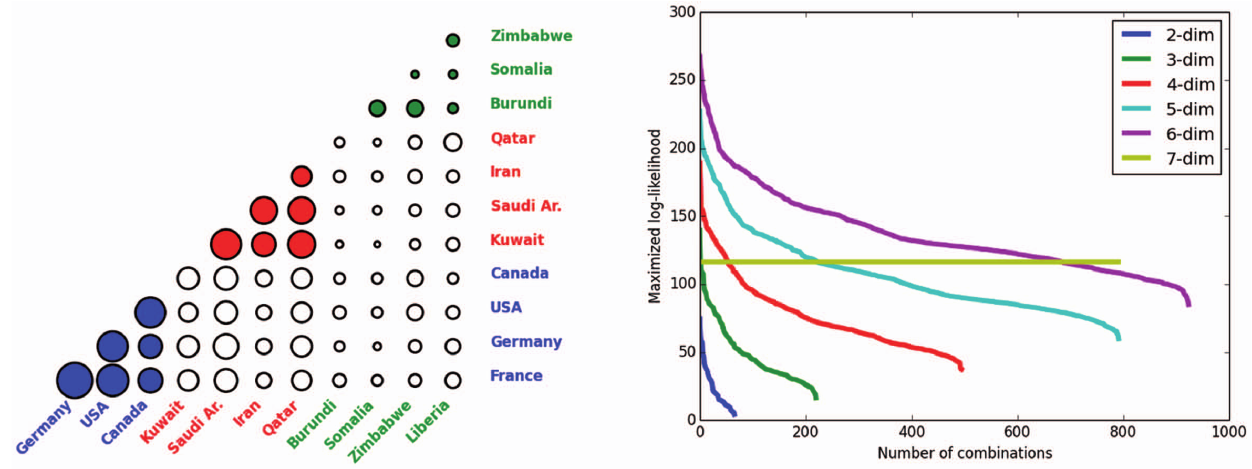
Figure 4. Log-likelihood plots. (Left) For each couple of countries, the figure shows circles whose areas correspond to the maximum log- likelihood values of the bivariate copulas. The colours are used to identify the countries belonging to the same cluster. (Right) For different dimensions of the copula function, the figure shows the maximum log-likelihood values for each possible combination of countries, in decreasing order.